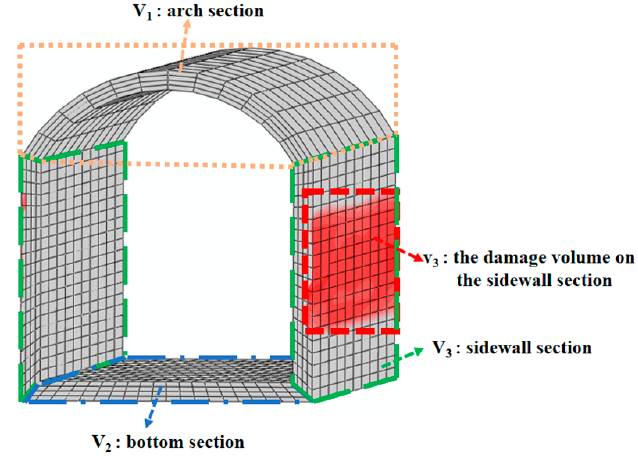
Figure 10. Schematic diagram of the damage volume [36].